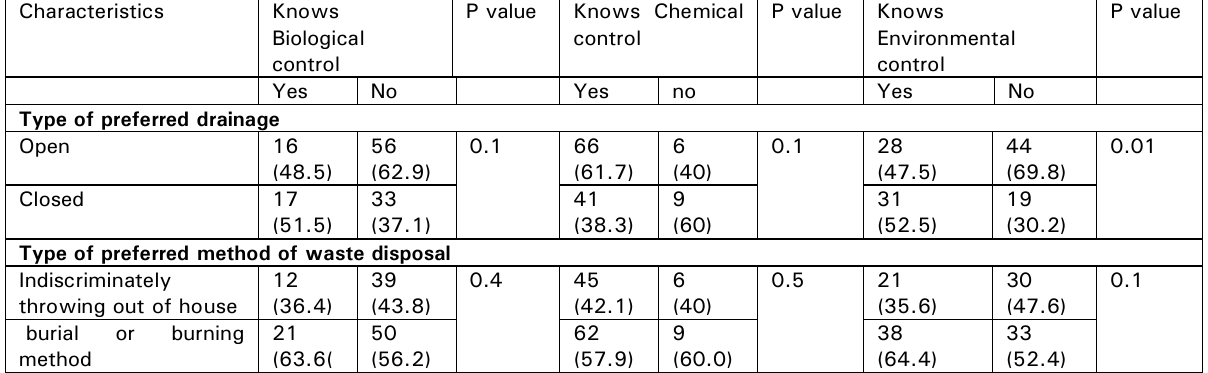
Table 4. Association of selected practices and knowledge on control of vectors (n=122)